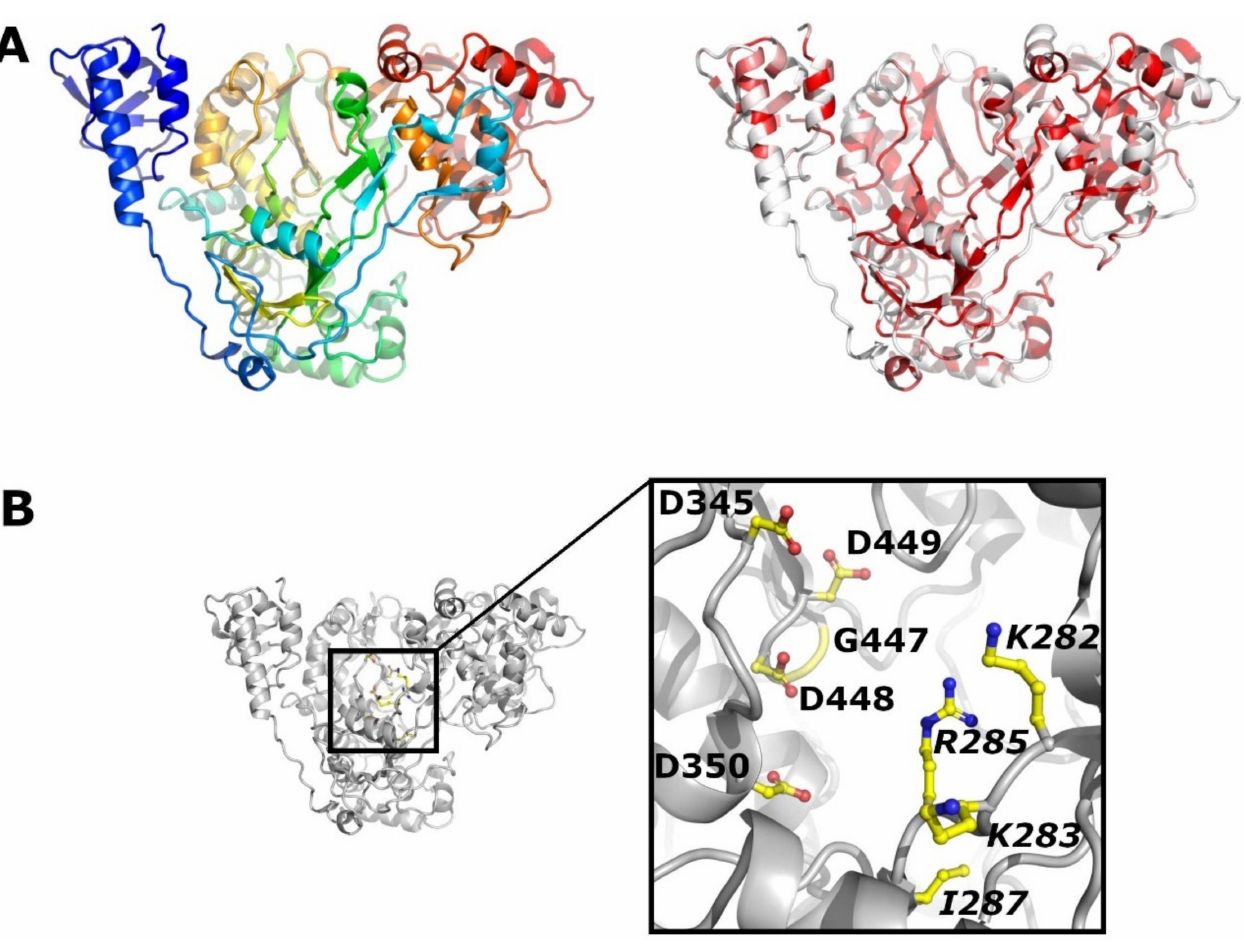
Figure 8. Crystal structure of NS5B. ( A ) Cartoon representation of NS5B (PDB code 5Y6R). On the left, NS3 is coloured from the N terminus (blue) to the C terminus (red). On the right, NS5B is coloured according to sequence conservation from white (non-conserved) to red (conserved). ( B ) The catalytic aspartate residues (D345 and S350) as well as the GDD motif (447–449) are shown as sticks. Important finger domain residues (K282, K283, R285 and I287) are labelled in